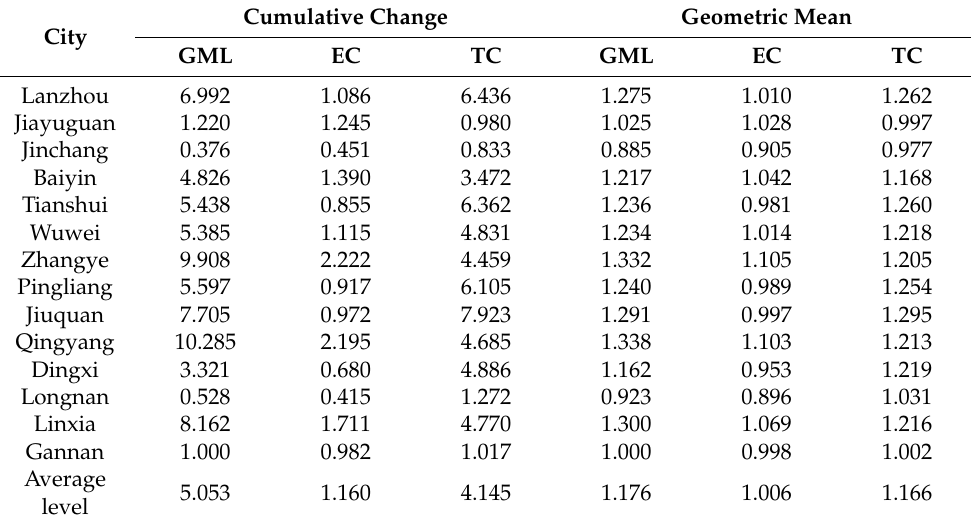
Table 2. The GML index of the tourism efficiency of 14 cities in Gansu Province. Cumulative City